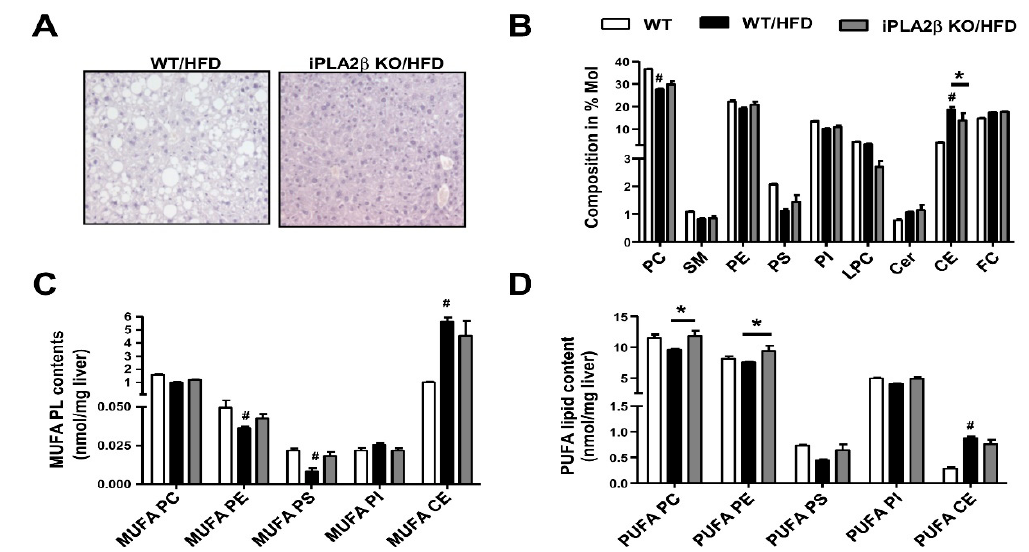
Figure 4. Inactivation in HFD-fed mice rescues the defect of hepatic PL remodeling. Male WT and iPLA 2 β KO mice at six months old were fed with HFD for six months. ( A ) Representative photographs of hematoxylin- and eosin-stained livers of HFD-fed WT and iPLA 2 β KO mice. ( B ) The composition of PLs and CEs. ( C ) The contents of PLs and CEs containing MUFA. ( D ) The contents of PLs and CEs containing PUFA. Data are mean ± SEM, N = 5–12; #, p < 0.05, versus WT; *, p < 0.05, WT/HFD versus iPLA 2 β KO/HFD.